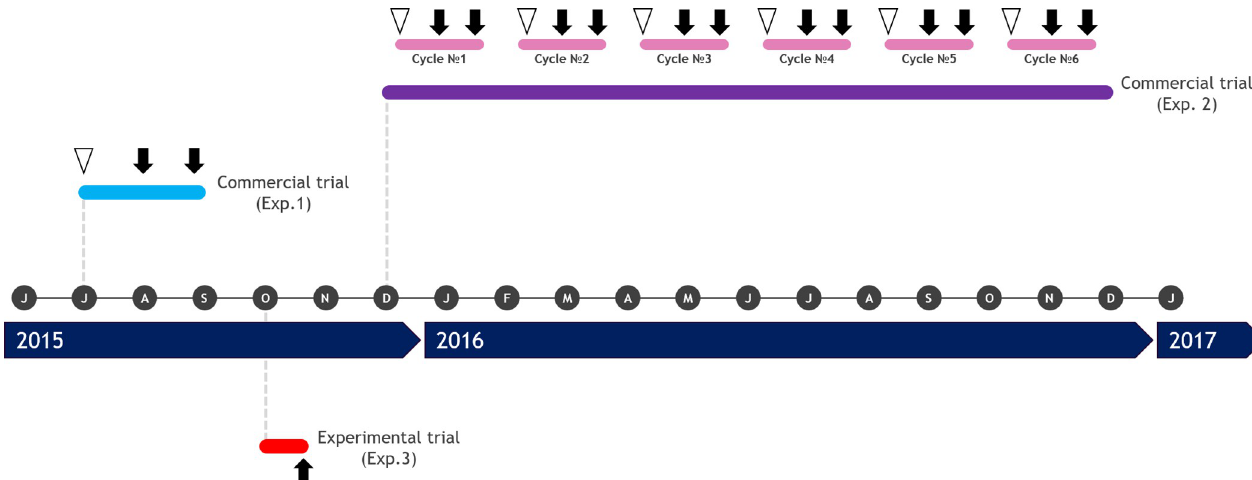
Fig 1. Experimental design and time course of the included experiments. Experiment numbers represent the order in which they were designed and planned. White triangles indicate farms visits to control overall conditions of the birds at arrival. Black arrows indicate necropsies for gross lesions inspection and sample